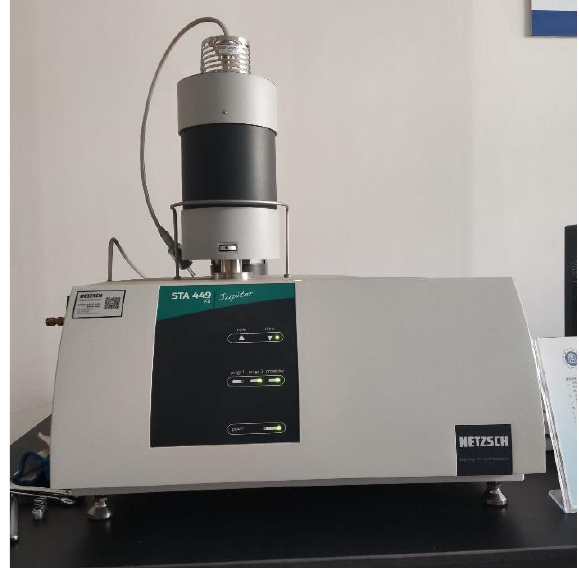
Figure 2. The picture of STA 449Thermal analyzer.